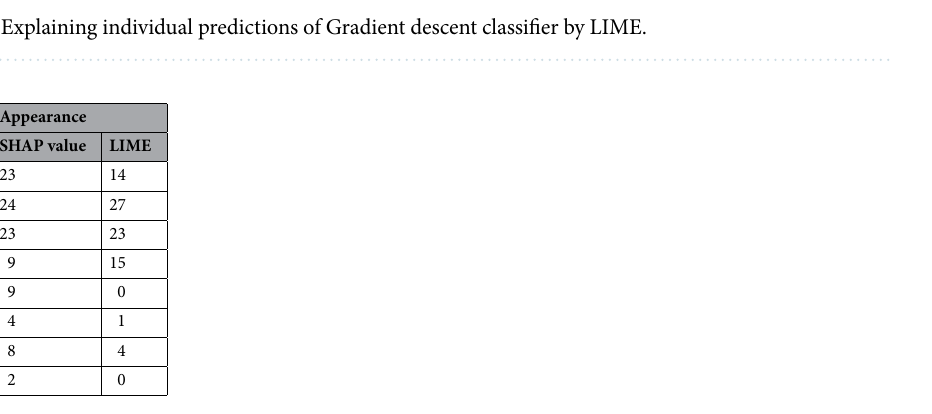
Table 4. The top selected feature in the case of Severity for both explainers.